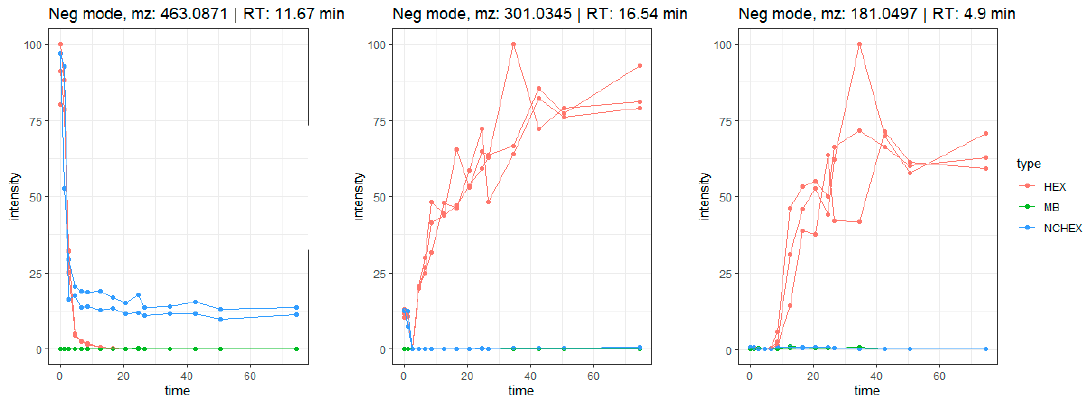
Figure 8. Time profiles of biotransformation of isoquercetin ( m/z 463.0871 [M-H] − ), quercetin ( m/z 301.0345 [M-H] − ) and a metabolite ( m/z 181.0497 [M-H] − ) tentatively identified as 3,4- dihydroxyphenylpropionic acid or 3-methoxy-4-hydroxyphenylacetic acid.